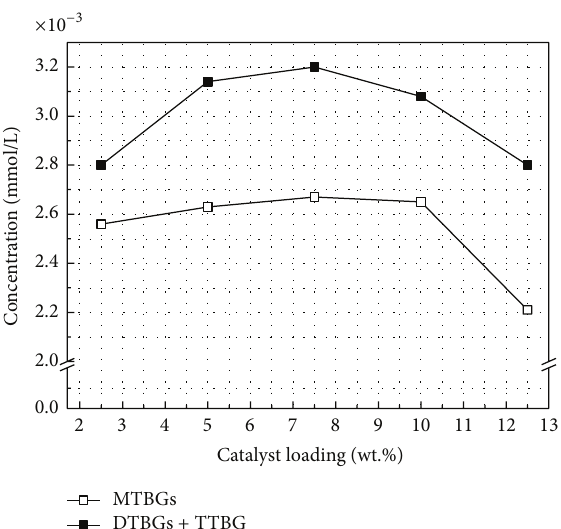
Figure 4: Influence of catalyst loading on product yield. Reaction conditions: 70 ∘ C, TBA to glycerol molar ratio = 4: 1, and 8 hours.